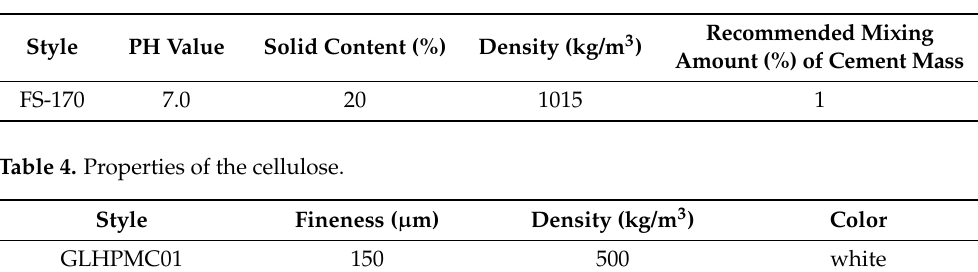
Table 3. Properties of the silicone hydrophobic agent.